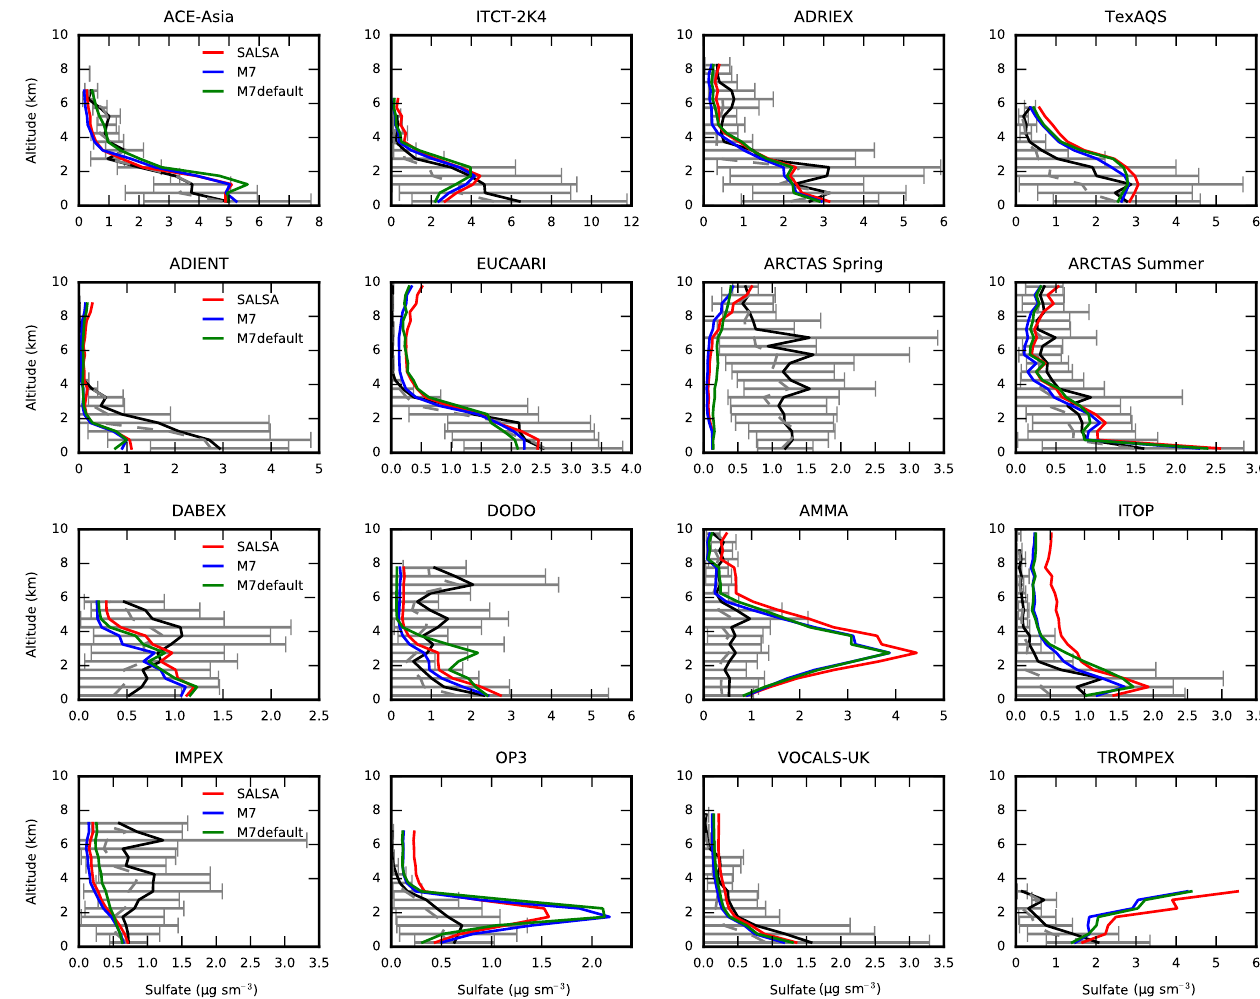
Figure 13. Observed and modeled mean vertical profiles of SU in aircraft measurement campaigns. Black curves represent the measured SU concentrations and the gray whiskers show the variability in